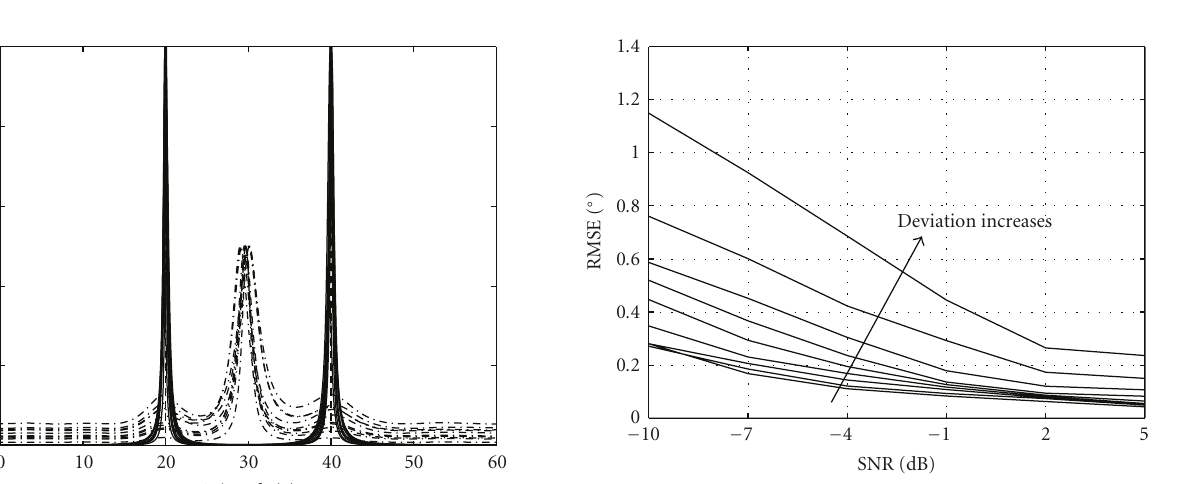
Figure 2: RMSE of the proposed method exploiting di ff erent single spectral frequencies.